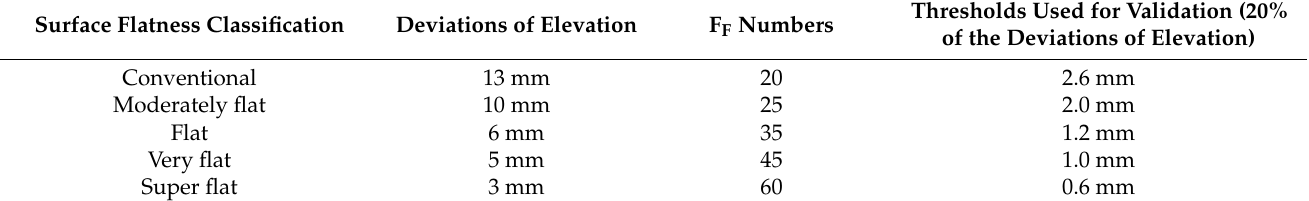
Table 1. F F numbers, its deviations of elevation and thresholds used for validation for 5 different types of concrete slabs specified in ACI 117 [2].